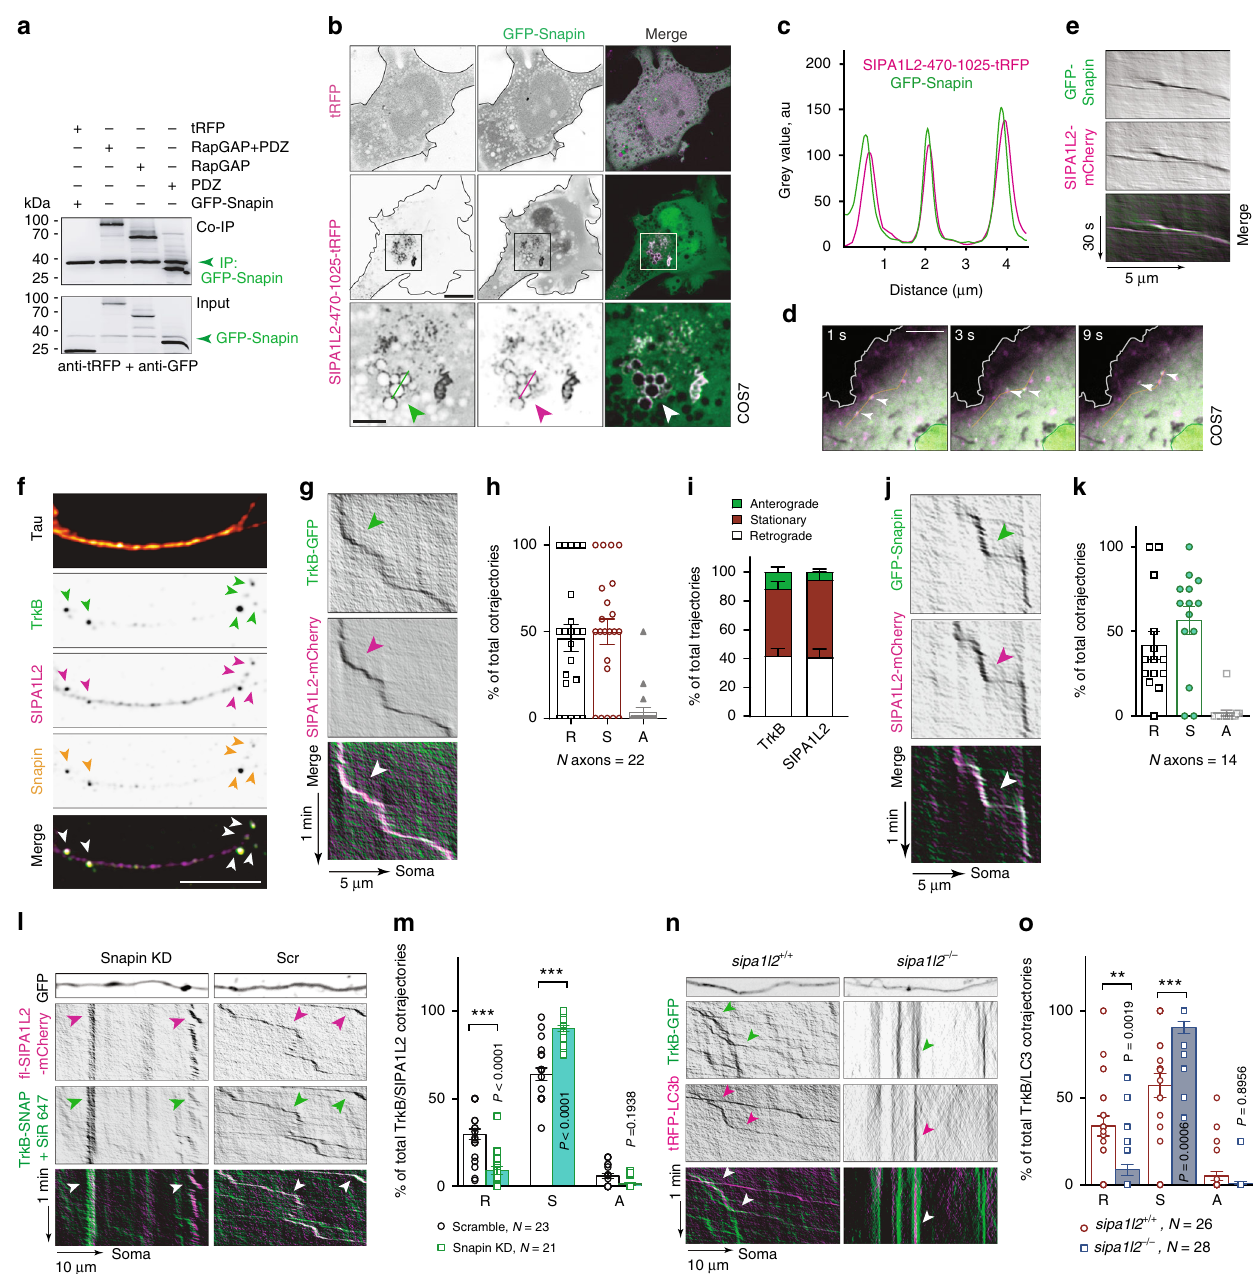
Fig. 3 SIPA1L2 associates and cotraf fi cks with Snapin and TrkB. a GFP-Snapin coimmunoprecipitates RapGAP- and PDZ-SIPA1L2-tRFP from HEK293T cells extracts. The upper blot shows the signal from the anti-tagRFP and anti-GFP antibodies. Green arrow indicates immunoprecipitated GFP-Snapin. The lower blot represents the input. Note that the anti-tRFP antibody used also recognizes GFP. b , c Representative images ( b ) from the recruitment assay performed in COS7 cells using SIPA1L2-470-1025-tRFP or tRFP as control and GFP-Snapin. Insets are shown in the lower panel. The line pro fi le ( c ) was generated from the line in the inset. d , e Snap-shots of fl -SIPA1L2-mCherry and GFP-Snapin cotraf fi cking in COS7 cells ( d ) and corresponding kymograph ( e ). Orange line in d represents the trajectory used for kymograph generation ( e ). f Confocal images from rat hippocampal neurons stained against TrkB, SIPA1L2, Snapin, and Tau. g , h Representative kymographs from neurons overexpressing TrkB-GFP and fl -SIPA1L2-mCherry. Relative motility of SIPA1L2/TrkB cotrajectories is indicated in h . Total number of cotrajectories is 84. i Relative motility of TrkB and SIPA1L2 as a percentage of total trajectories (TrkB = 284 trajectories; SIPA1L2 = 146; the number of axons is depicted in h ). j , k Representative kymographs from neurons overexpressing GFP-Snapin and fl -SIPA1L2-mCherry. Relative motility of SIPA1L2/Snapin cotrajectories is represented in k . Total number of cotrajectories is 60. l , m Representative kymographs from neurons overexpressing either shRNA-based Snapin KD or Scr control together with fl -SIPA1L2-mCherry and TrkB-SNAP ( + SiR647). GFP represents transfection control. Relative motility of SIPA1L2/TrkB cotrajectories is depicted in m . N = analyzed axons (nonparametric Kolmogorov-Smirnov test). n , o Representative kymographs and quanti fi cation of a percentage of TrkB-GFP/tRFP-LC3b cotrajectories in sipa1l2 − / − as compared to sipa1l2 + / + mouse hippocampal neurons. (nonparametric Kolmogorov-Smirnov test; N number corresponds to axons). Representative kymographs ( g , j , l , n ) were generated from axons of rat hippocampal neurons. Relative motility ( h , k , m , o ) is shown as percentage of total cotrajectories. Bars and error bars represent data as mean±SEM. N number in the graph corresponds to the number of axons. Symbols in columns represent values from single axons. Arrows indicate cotrajectories. R retrograde, S stationary, A anterograde. Scale bars are 10 μ m ( b ) and 5 μ m ( b , inset; d – f ). "**" indicates P ≤ 0.01; "***" indicates P ≤